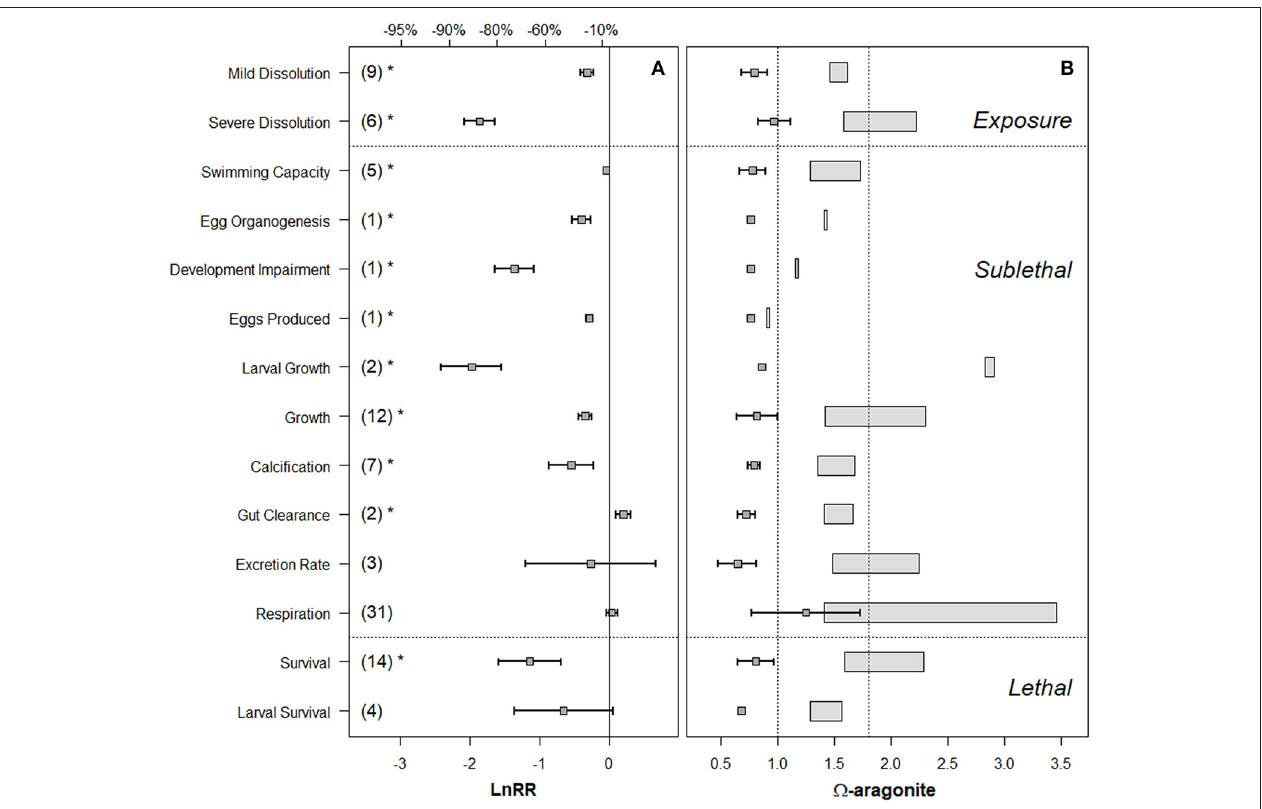
FIGURE 3 | (A) Forest plot of (cid:127) ar effect on various biological processes across exposure response, sublethal, and lethal responses in pteropods. The numbers in the parenthesis indicate the number of experiments for each response measure, error bars indicate 95% confidence intervals. LnRR (Logarithmic response ratio) indicates the magnitude of response with its significance ( p < 0.05) indicated by the asterisks. Percentage values along the top of the figure indicate percent decrease in the given endpoint, compared to the control. (B) “Effect” (box-and-whiskers) and “control” (rectangles) conditions as used in the experimental conditions, with the dotted line positioned at (cid:127) ar = 1 and 1.8 for comparison with known biogeochemical (cid:127) ar thresholds.